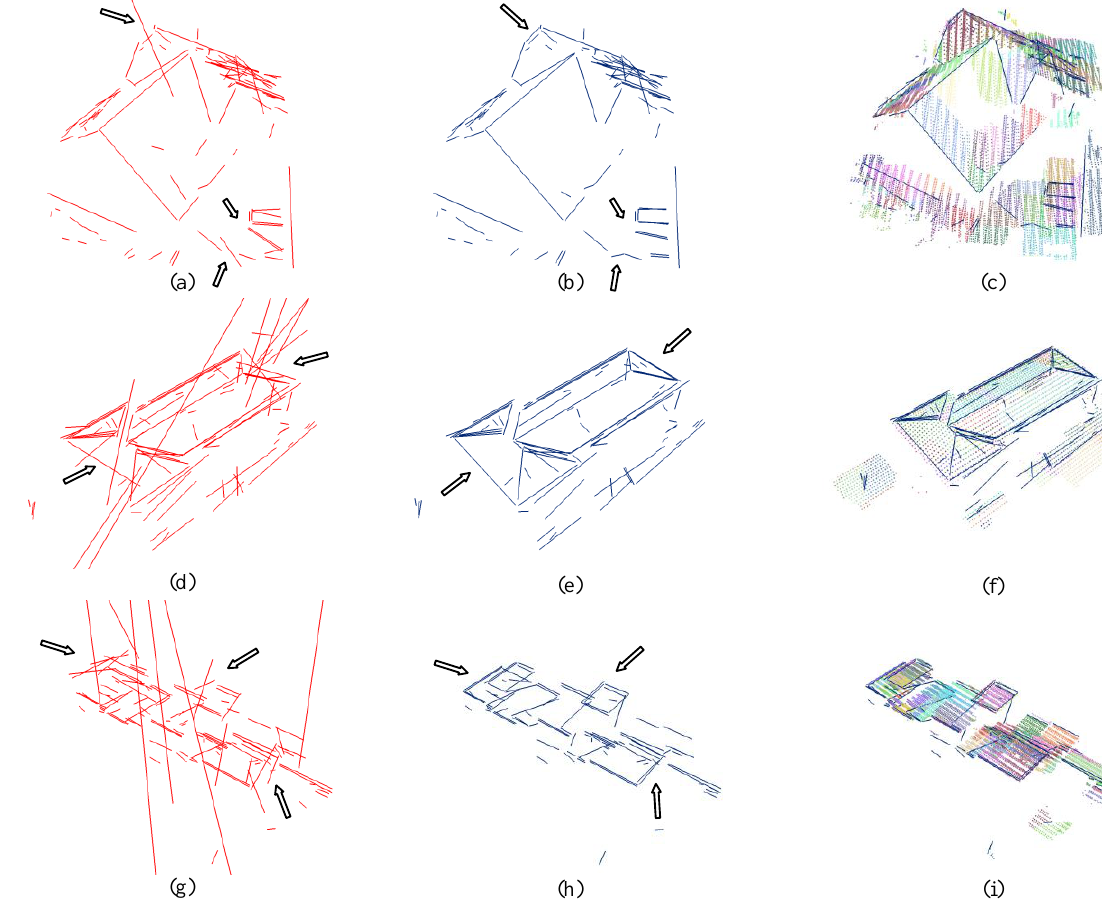
Fig. 8 3D line segments generated with the method of direct construction (a-d-g) and our approach (b-e-h). Block arrows point parts where some of the critical improvements are observed. The LIDAR point cloud overlaid with the lines reconstructed with our approach (c-f-i). Each color in the point cloud belongs to the automatically extracted 3D planes in the vicinity of each